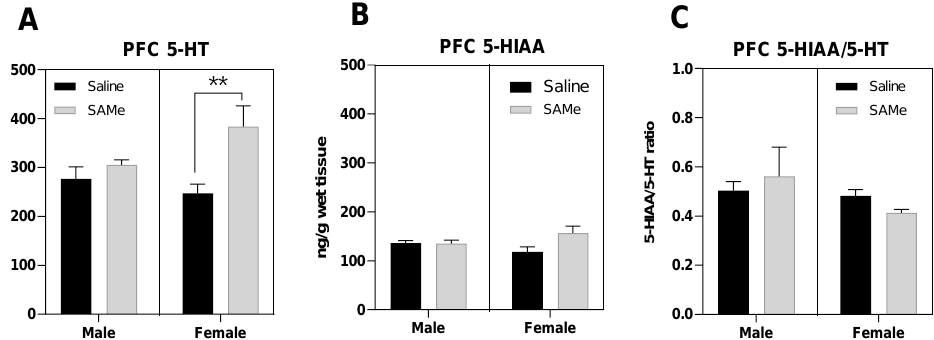
Figure 1. SAMe effects on Serotonin turnover in the PFC. SAMe treatment significantly elevated the levels of serotonin in a gender related manner. SAMe treatment effect was significant only in female Sub mice ( A ). ( B ) The levels of 5-HIAA were not changed by SAMe in both males and females. ( C ) the 5-HIAA/5-HT ratio remained unchanged following SAMe treatment in both male and female. The data are presented as mean ± SEM. Levels of 5-HT and 5-HIAA are presented in ng/g brain tissue, n ≥ 6 for each group. ** p < 0.01 compared to control mice of the same gender.